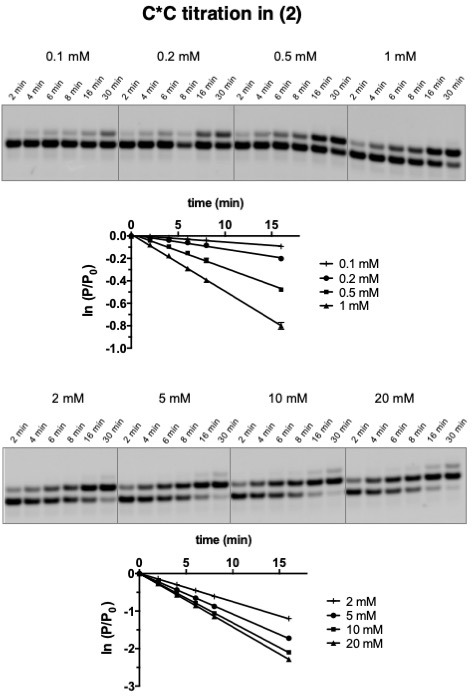
Representative denaturing PAGE data and plots of ln(P/P0) vs. time for the reaction kinetics in case (2) as described in Figure 4.